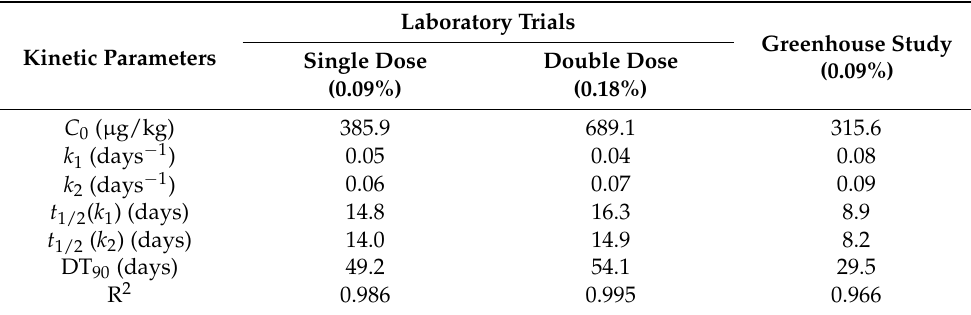
Table 1. Biphasic kinetic model parameters of flutriafol dissipation in laboratory (courgette samples) and greenhouse trials (tomato samples) 1 .